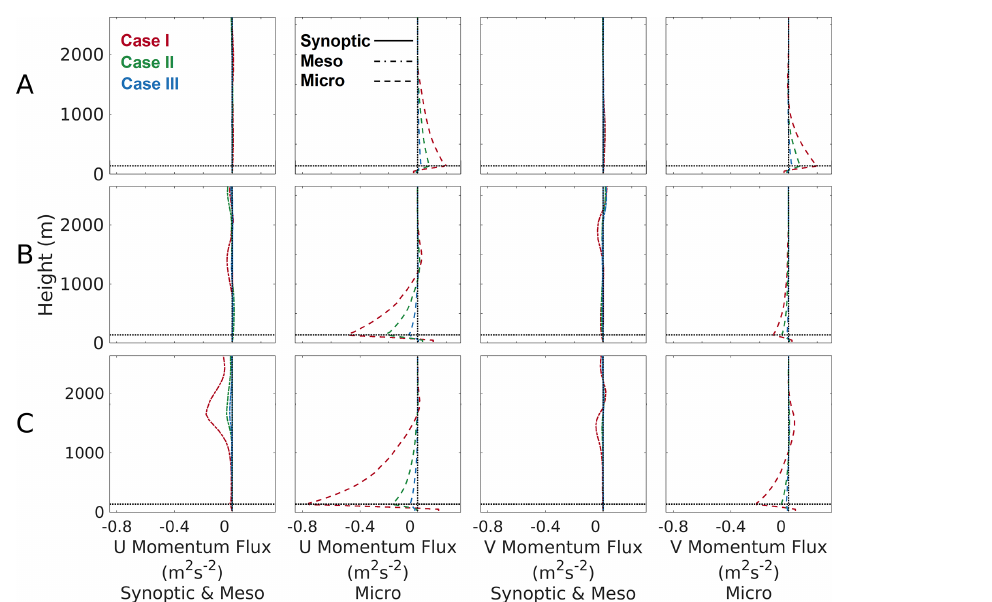
Figure 5. Difference (WF − CTRL) in vertical profiles of vertical synoptic-scale (solid line), mesoscale (dot-dashed line), and microscale fluxes (dashed line) averaged over the wind farm for the simulation period for (A) January, (B) June, and (C) July. The horizontal dotted black line shows the height of the upper tip of the wind turbine